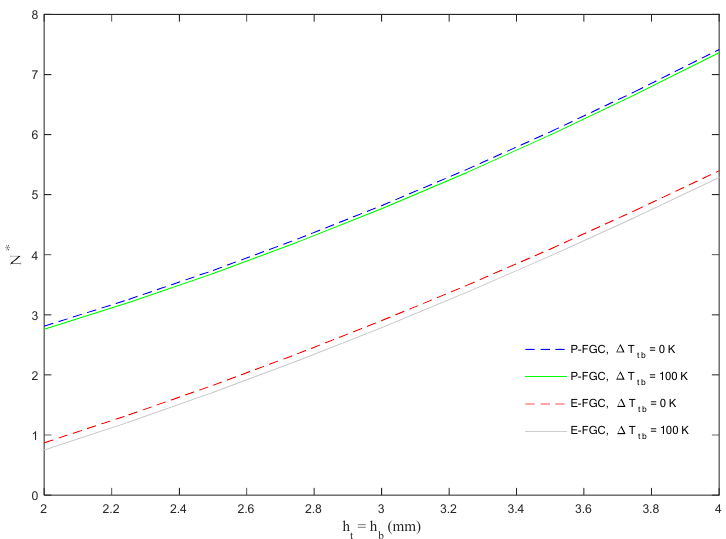
Figure 6. Dimensionless critical buckling load versus the core thickness for different moisture variations, based on E&P- FGC models.